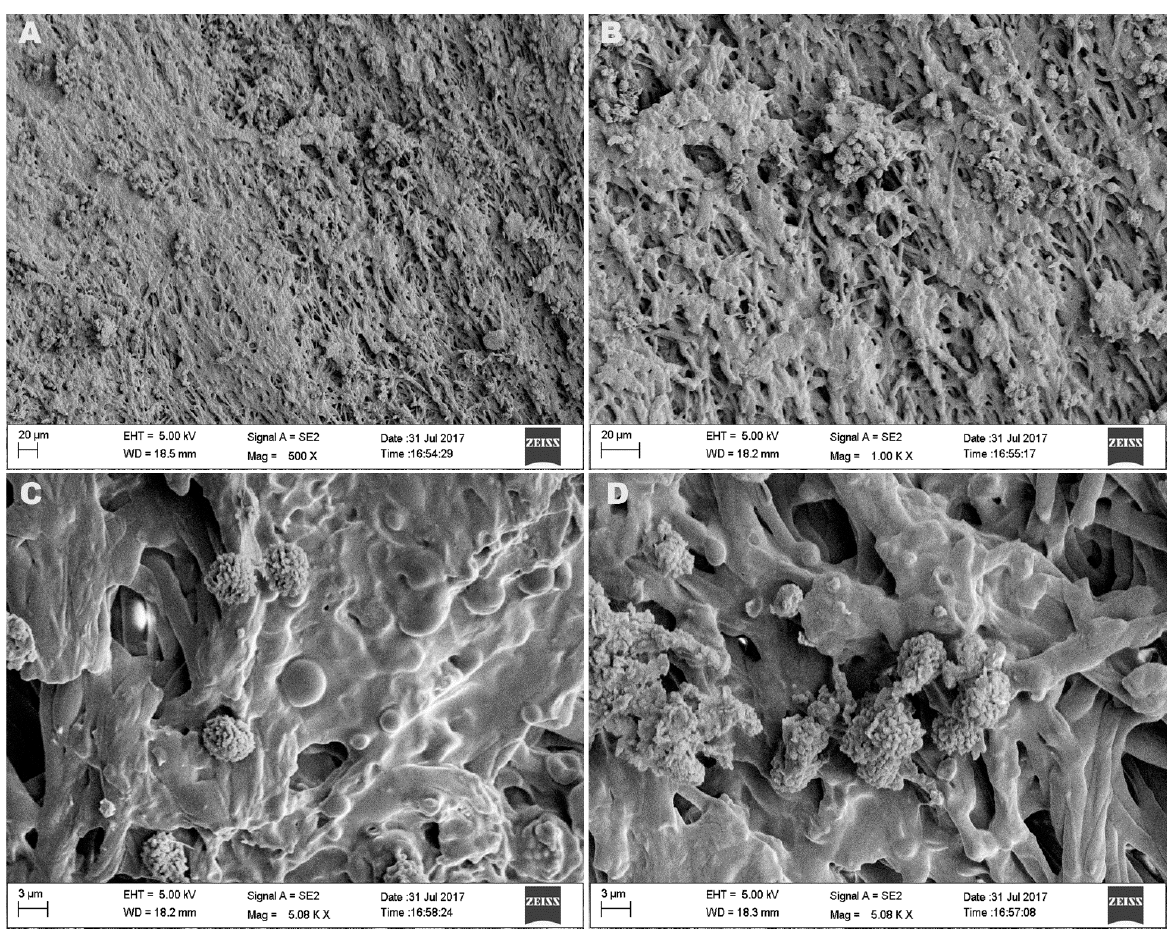
Figure 4. Scanning electron micrographs of the transverse, longitudinal cut sections of infected Dharam rice. ( A , B ), The chlamydospores of the fungal pathogen U. virens , along with the hyphae, spread throughout the interior of the infected grain; bar ( A , B ) = 20 μ m; ( C , D ) also at higher magnification; bar ( C , D ) = 3 μ m.